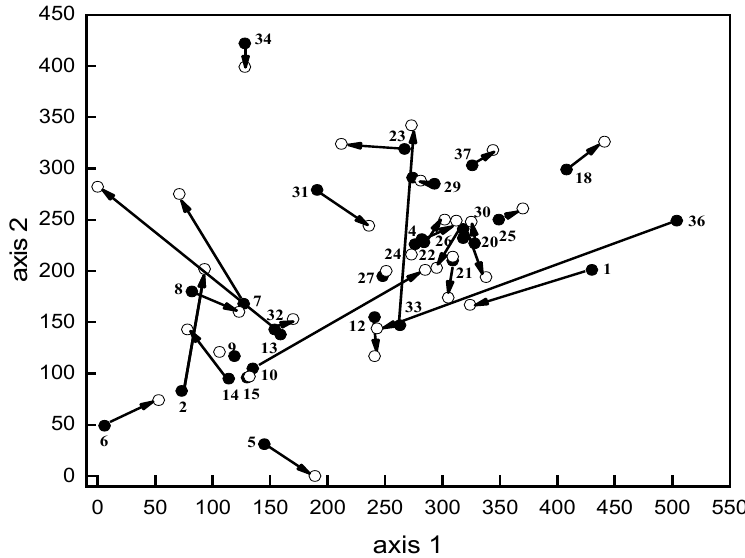
Figure 4. The detrended correspondence analysis (DCA) ordination of the enclosures according to the importance value data (cover). Open circles represent the inside vegetation, solid circles represent the outside vegetation, and arrows represent the direction of change.